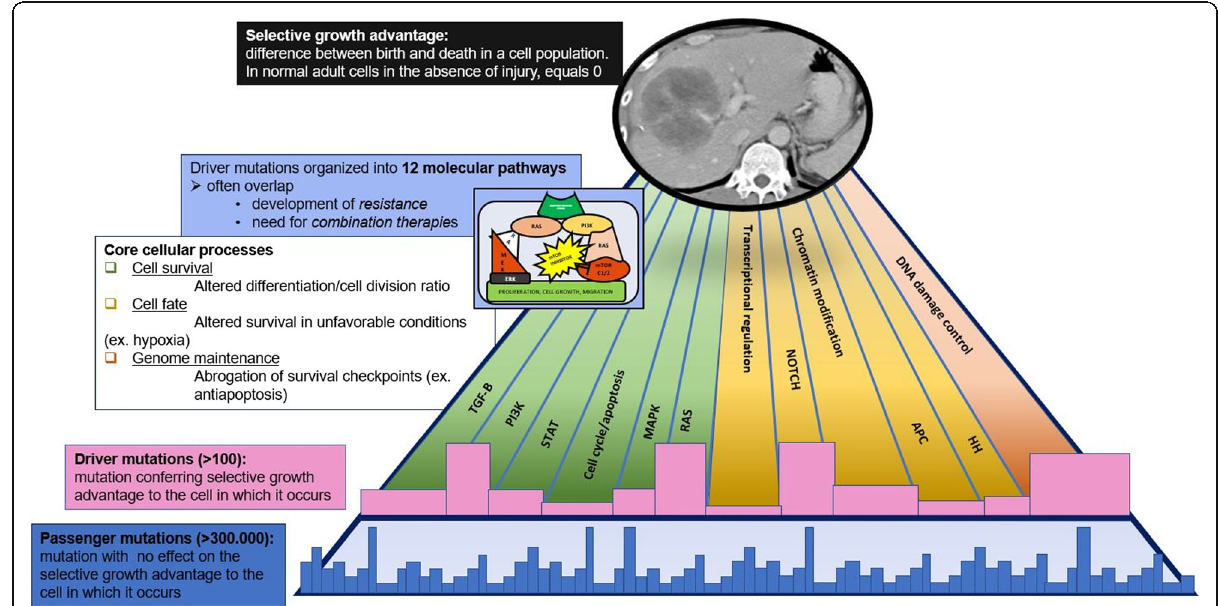
Fig. 1 Cancer genome landscapes: structure and